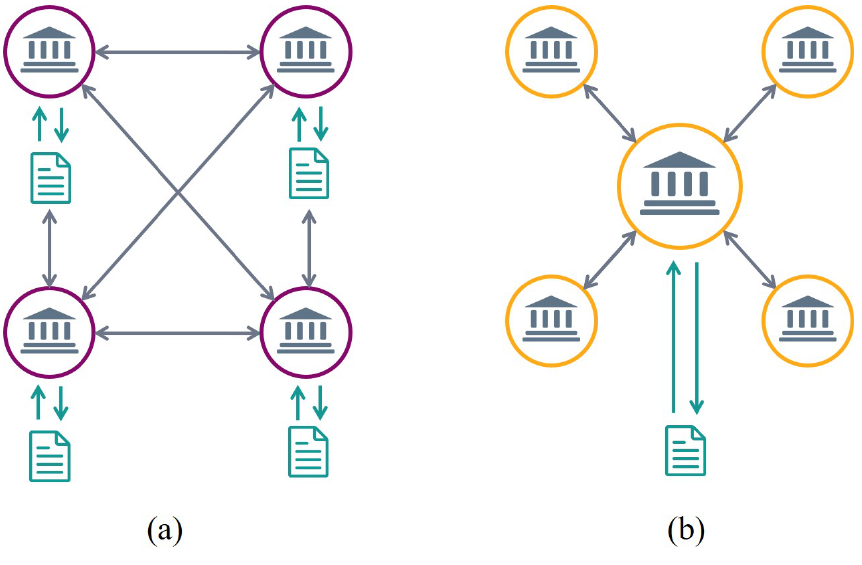
Figure 3. Implementation of; ( a ) Distributed Ledger Technology (DLT) and ( b ) Blockchain (Cen- tralised Ledger).